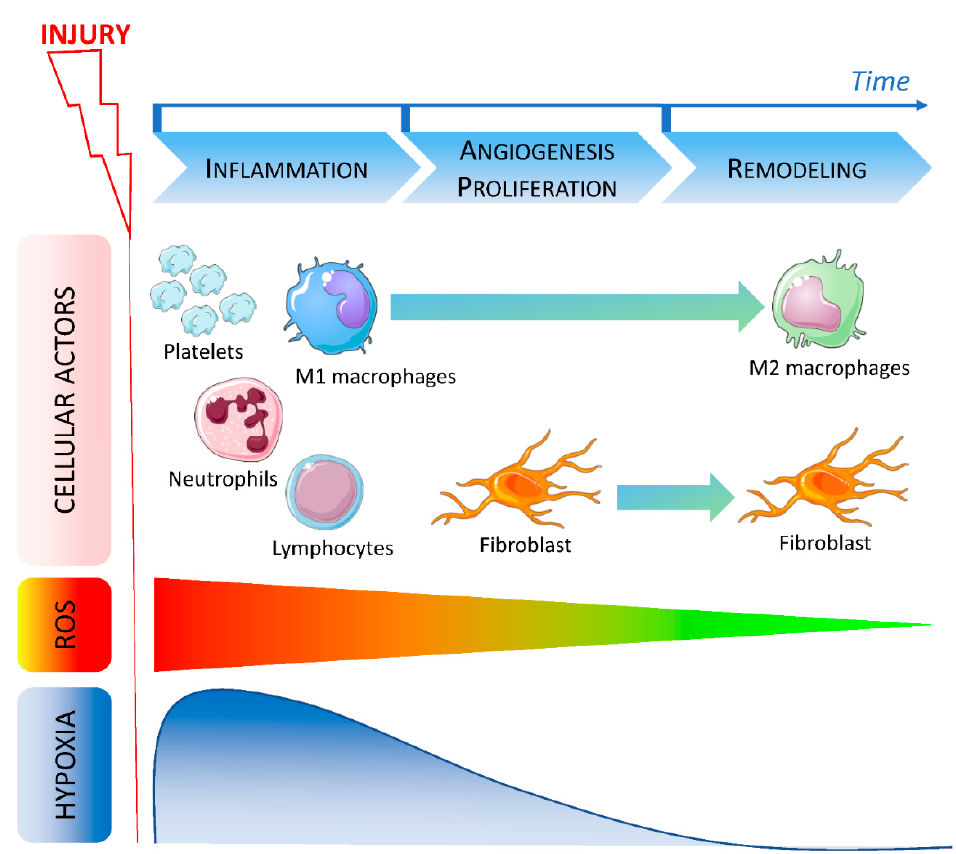
Figure 1. Timeline of cellular actors, ROS and hypoxia involved in wound healing. After injury, various cells are recruited during the early phase of wound healing. During the inflammation stage, platelets first migrate to the site of the injury to induce coagulation followed by neutrophils. At the same time, ROS level increases while local oxygen concentration decreases leading to hypoxia. Lymphocytes and M1 macrophages are then recruited and promote inflammation. During the angiogenesis and proliferation stage, fibroblasts migrate to the wound and macrophages polarization is modified. Hy- poxia is reduced and ROS level decreases indicating the beginning of the late phase. Dur- ing the remodeling phase, macrophages are polarized in an M2 resolving phenotype and fibroblasts are still present. ROS return to a physiological low level and hypoxia is abol- ished. Disturbance at any point in the wound healing process can contribute to pathological wound like fibrosis or non-healing wound. 2.1. Macrophages in Wound Healing Process Macrophages are major contributing cells in the wound healing process following organ damage either induced by infection, autoimmune disorders, mechanical or toxic injuries. Evidence demonstrates that macrophages depletion reduces inflammatory re- sponses whereas macrophages activation reduces recovery responses [13,17]. Beside tis- sue resident macrophages, bone marrow-derived macrophages, along with neutrophils, are among the first cells recruited to the site of injury. Their role, widely reviewed within the past years, is described at each step of tissue repair allowing them to be grouped into three types of activation. Firstly, early research highlighted their pro-inflammatory and scavenging contribution to the inflammatory stage [18,19]. Cellular response is then initi- ated by secreted inflammatory mediators (chemokines, ROS, matrix metalloproteases) leading to pathogens killing and phagocytosis [20,21]. At this stage, macrophages are